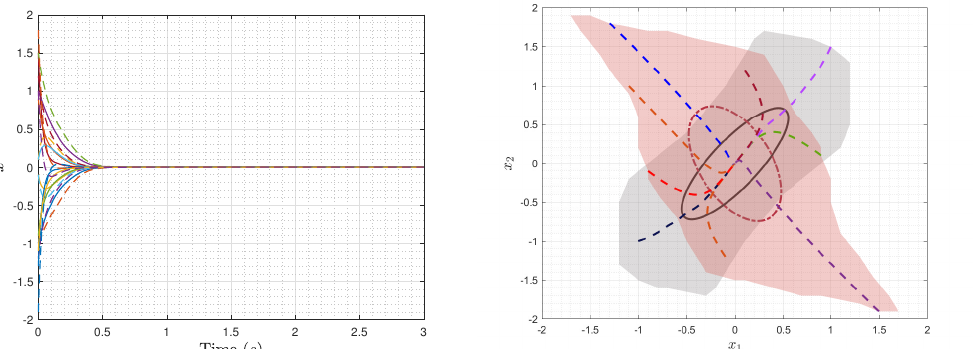
Figure 4. State x = [ x 1 ; x 2 ] converges to the origin for all x 0 ∈ F N